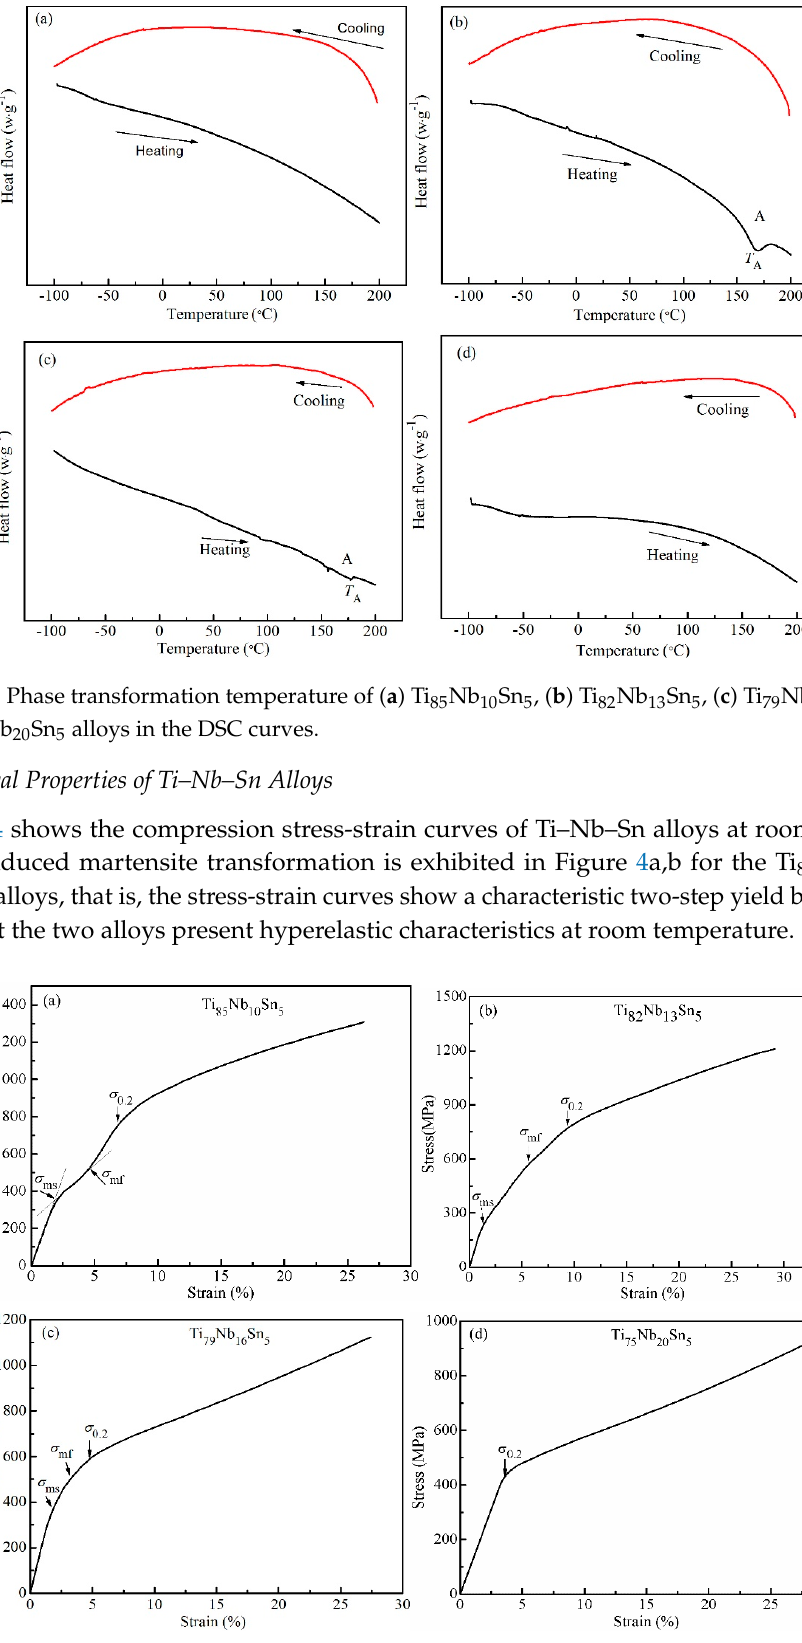
Figure 4. Stress-strain curves of ( a ) Ti 85 Nb 10 Sn 5 , ( b ) Ti 82 Nb 13 Sn 5 , ( c ) Ti 79 Nb 16 Sn 5 and ( d ) Ti 75 Nb 20 Sn 5 alloys.